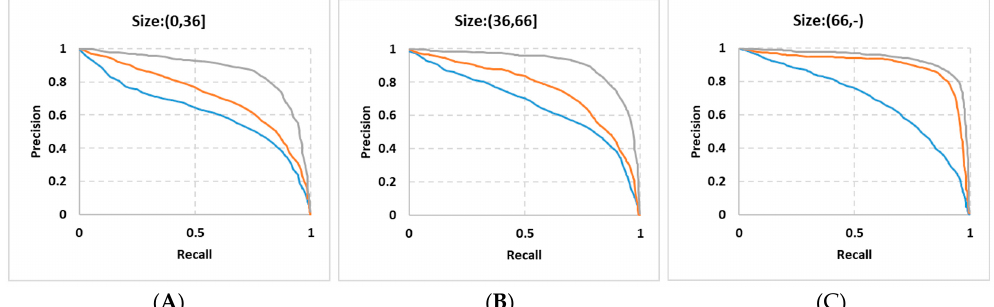
Figure 16. The Precision-Recall Curves, ( A ) on small traffic signs, ( B ) on medium traffic signs, ( C ) on large traffic signs; the blue lines represent the method of the original Faster R-CNN, the orange lines represent our method without SROIs information support, the gray lines represent our method with SROIs.